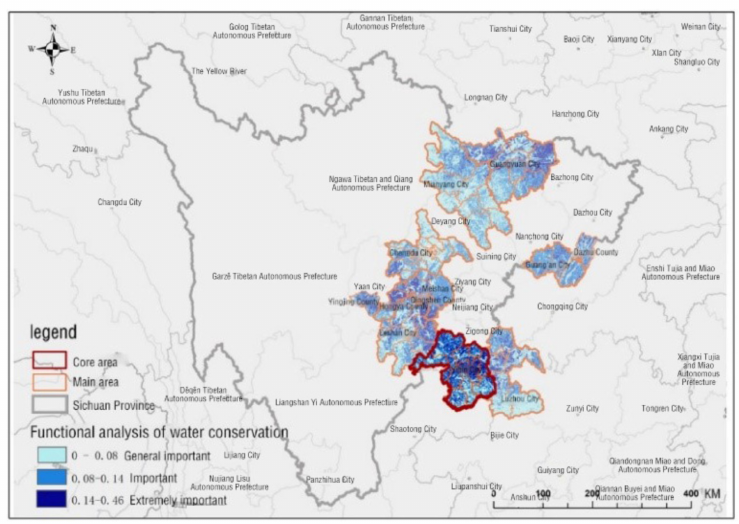
Figure 9. Water conservation function analysis of research areas in Sichuan